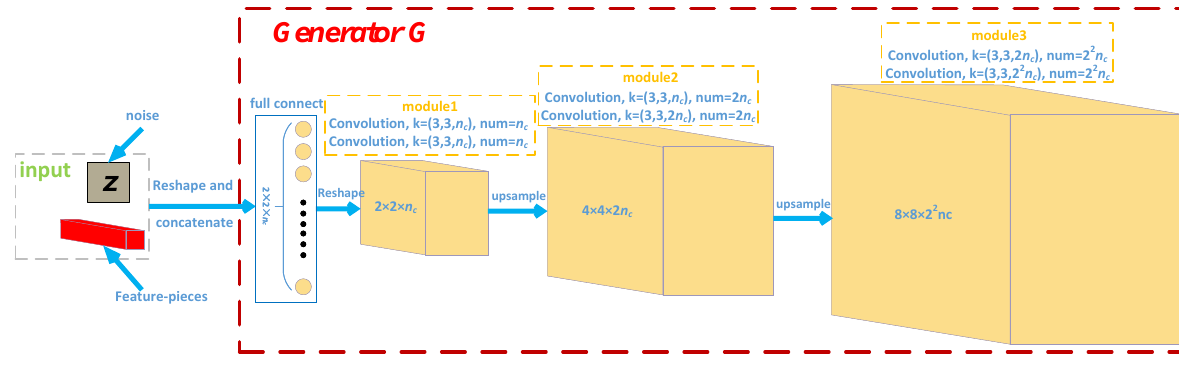
Figure 9. The structure of generator G . Table 1. The parameters of generator G